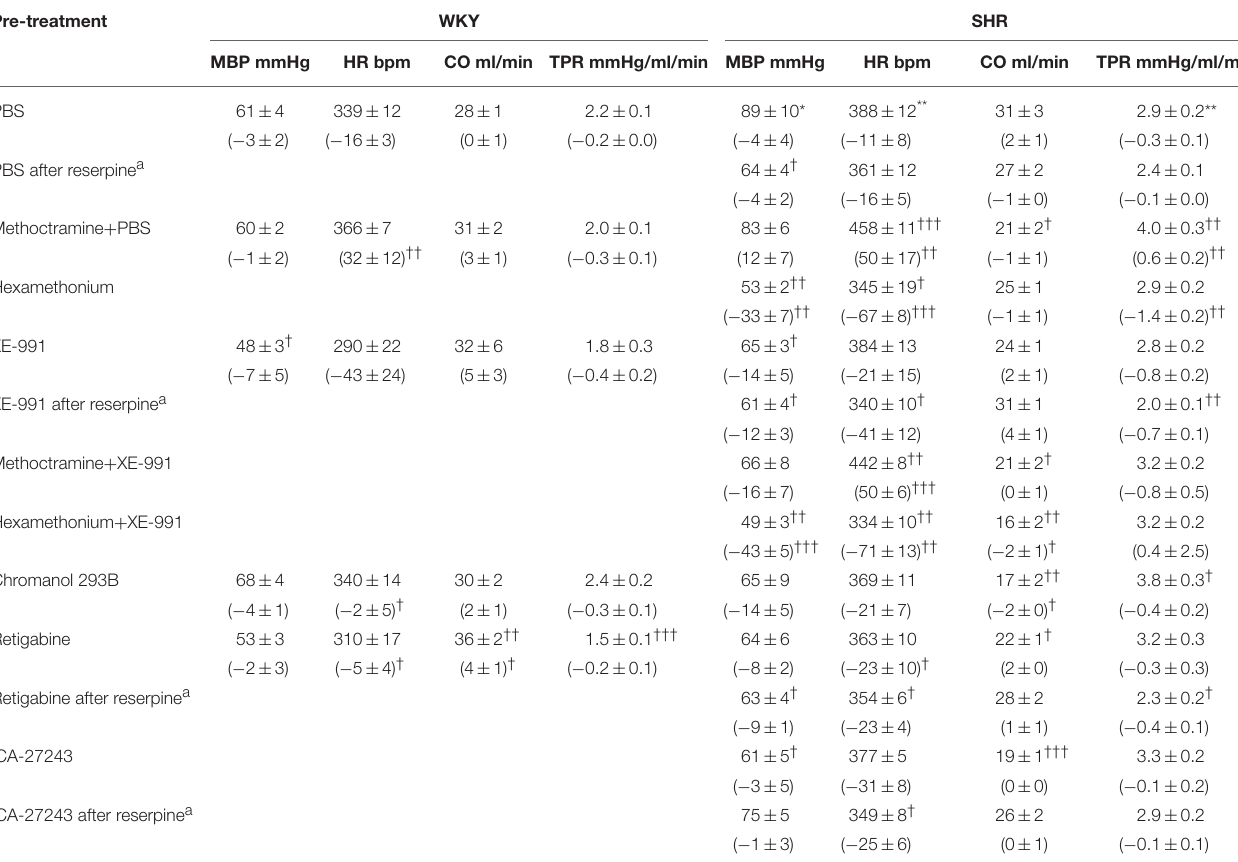
TABLE 1 | Cardiovascular baselines after pre-treatment, and the response to pre-treatment below in parenthesis.